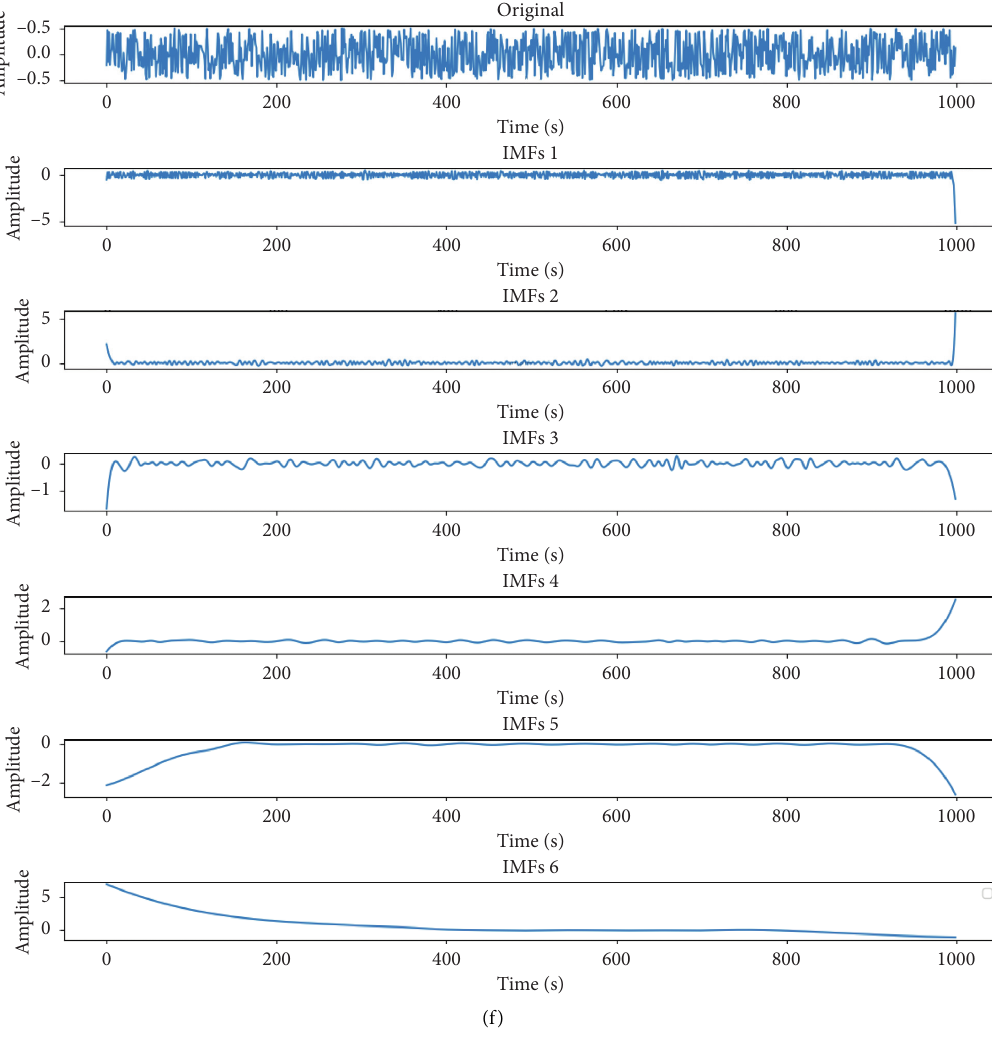
Figure 13: Cubic spline interpolation and INFs of EMD. The two faults are large gear broken teeth and small gear wear and large gear pitting and small gear